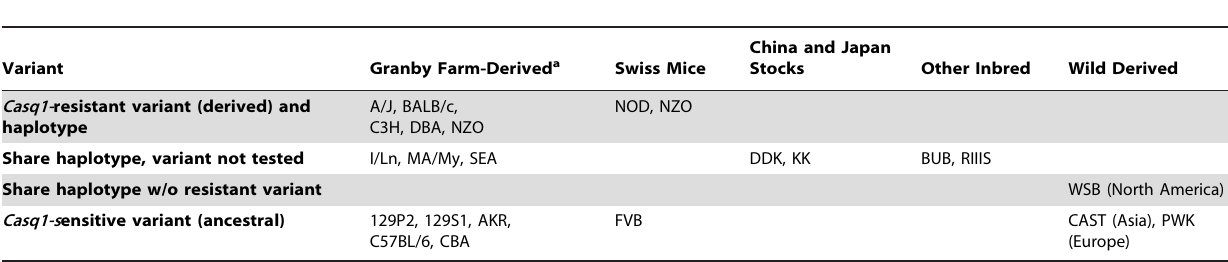
Table 1. TNNI3 interacting kinase–Heart failure modifier 2 ( Tnni3k Hrtfm2 ) variant is widely distributed in laboratory mice.